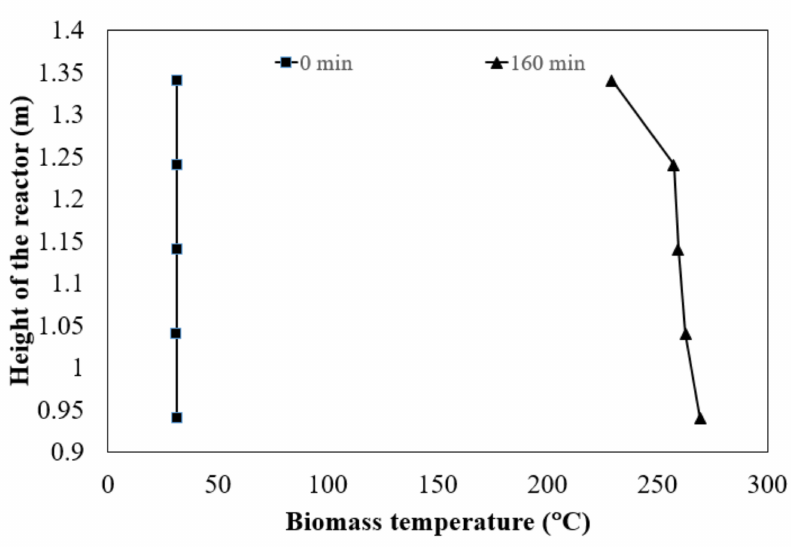
Figure 5. The temperature distribution of cassava rhizome in the reactor with thermosyphon at heating chamber temperature of 450 ◦